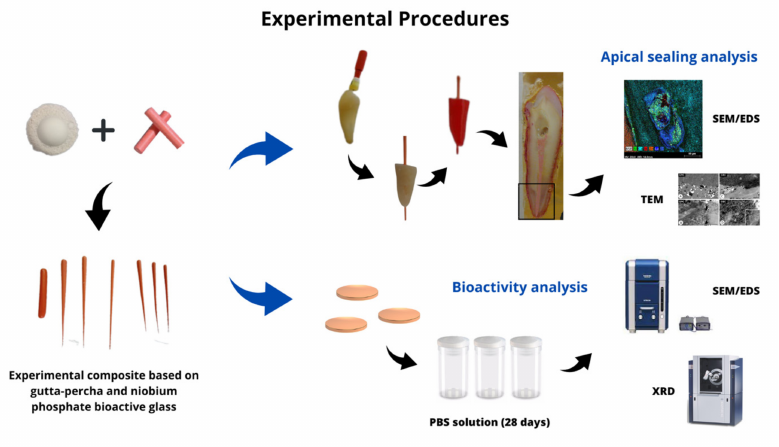
Figure 1. Summary of the sample preparation and experimental procedures adopted for the apical sealing and bioactivity